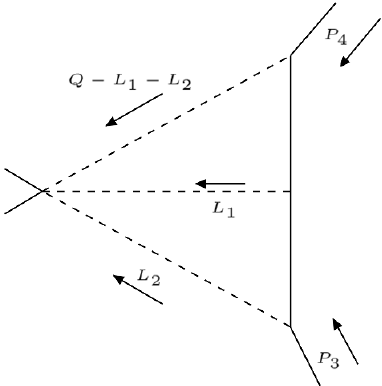
Figure 5. 2-loop nested triangle. The solid lines represent massive particles exchanging massless states, represented by dashed